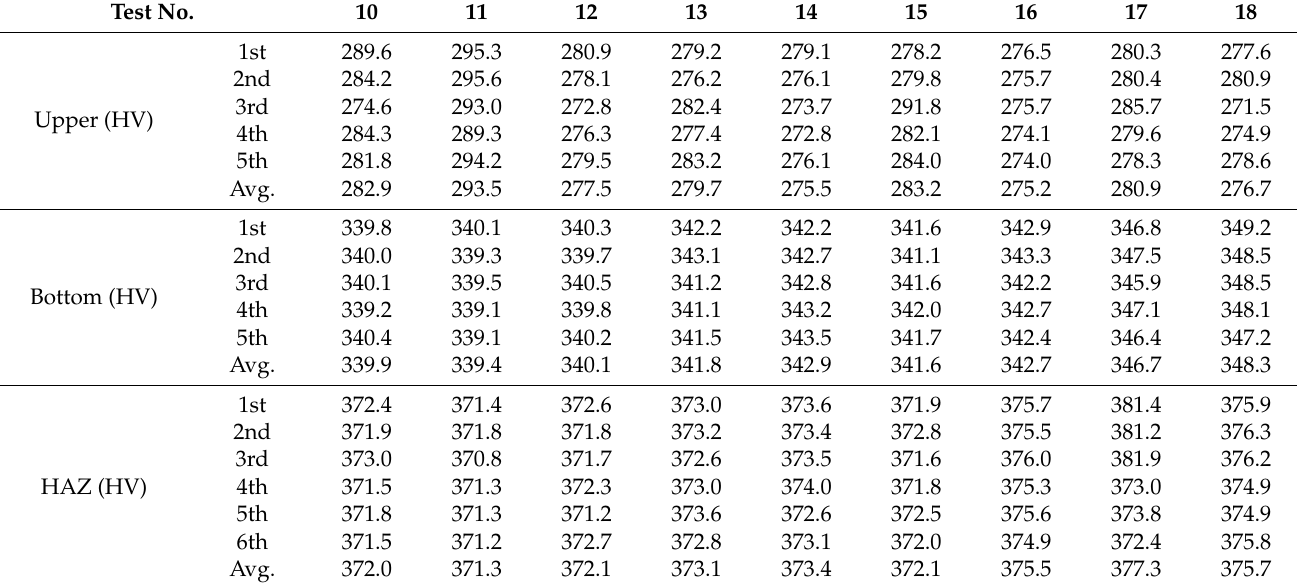
Figure 6. Optical microscope for dilution ratio measurement. Table 7. Results of dilution ratio for fiber laser welding. Test No.